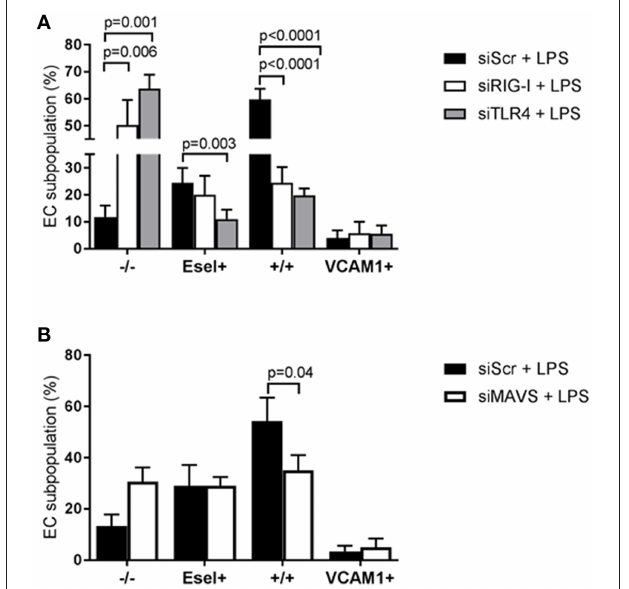
FIGURE 6 | LPS-mediated E-selectin/VCAM-1 HUVEC subpopulations are regulated by different downstream signaling mechanisms. (A) The effect of pharmacologically inhibiting NF- κ B with BAY 11-7082 (BAY) and p38 MAPK with LY2228820 (LY) pre-treatment on the formation of the LPS-induced EC subpopulations based on E-selectin and VCAM-1 expression, after 2h of LPS exposure; and (B) after 4h of LPS exposure. Bars represent the mean ± SD of 4 independent experiments. p < 0.05 is considered statistically